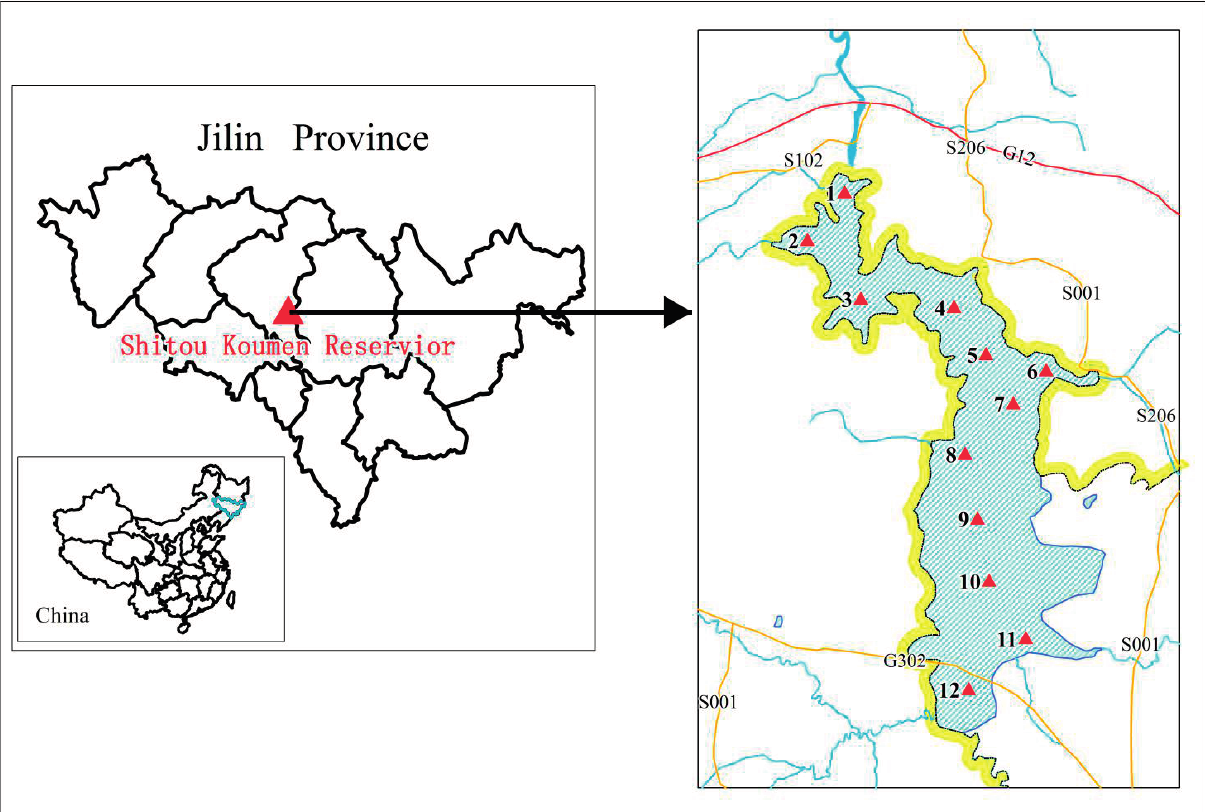
Figure 1. The locations of the Shitou Koumen Reservoir and the sampling